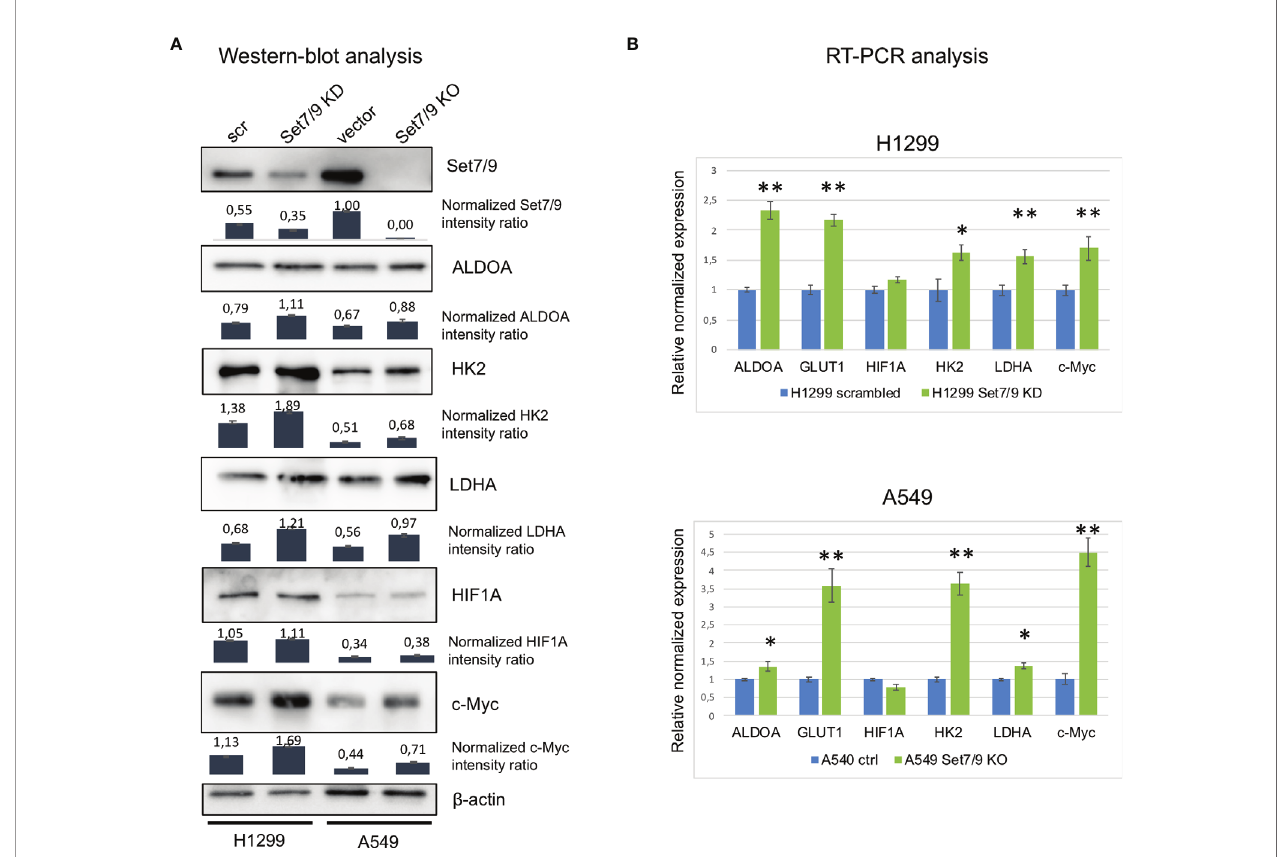
FIGURE 2 | The effect of Set7/9 decrease on ALDOA, GLUT1, LDHA, HK2, HIF1A, and c-Myc levels. (A) Western blot analysis of ALDOA, LDHA, HK2, HIF1A, and c-Myc levels in NSCLC cell lines H1299 knockdown (Set7/9 KD) and A549 with Set7/9 knockout (Set7/9 KO) compared to control (scrambled or vector) cells. Densitometry analysis was performed on the basis of three measurements. Error bars indicate ± SD; (B) Quantitative RT-PCR: analysis of ALDOA, GLUT1, LDHA, HK2, HIF1A, and c-Myc mRNAs in the above cells. *p < 0.05; **p <